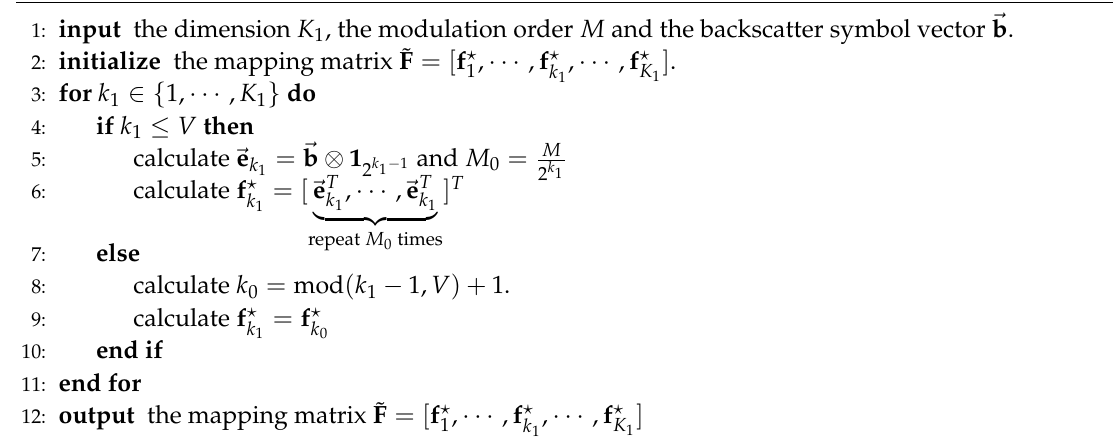
Algorithm 1 Constellation Mapping Matrix